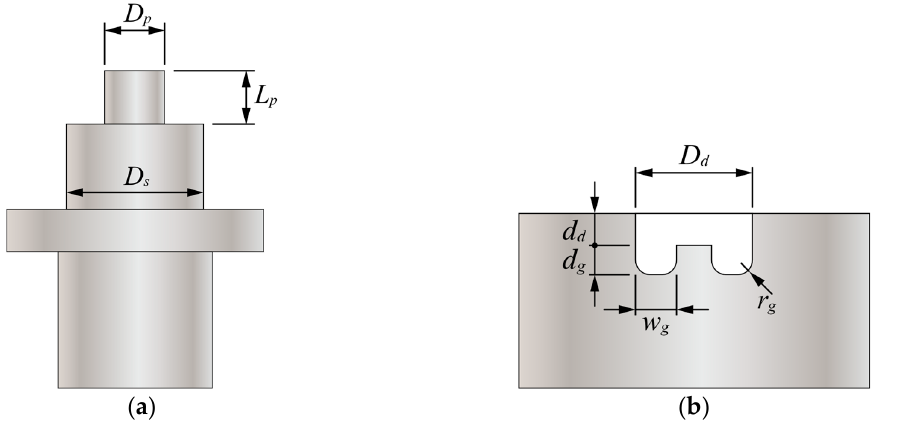
Figure 4. Designs of ( a ) a circular punch and ( b ) a circular die with a groove.